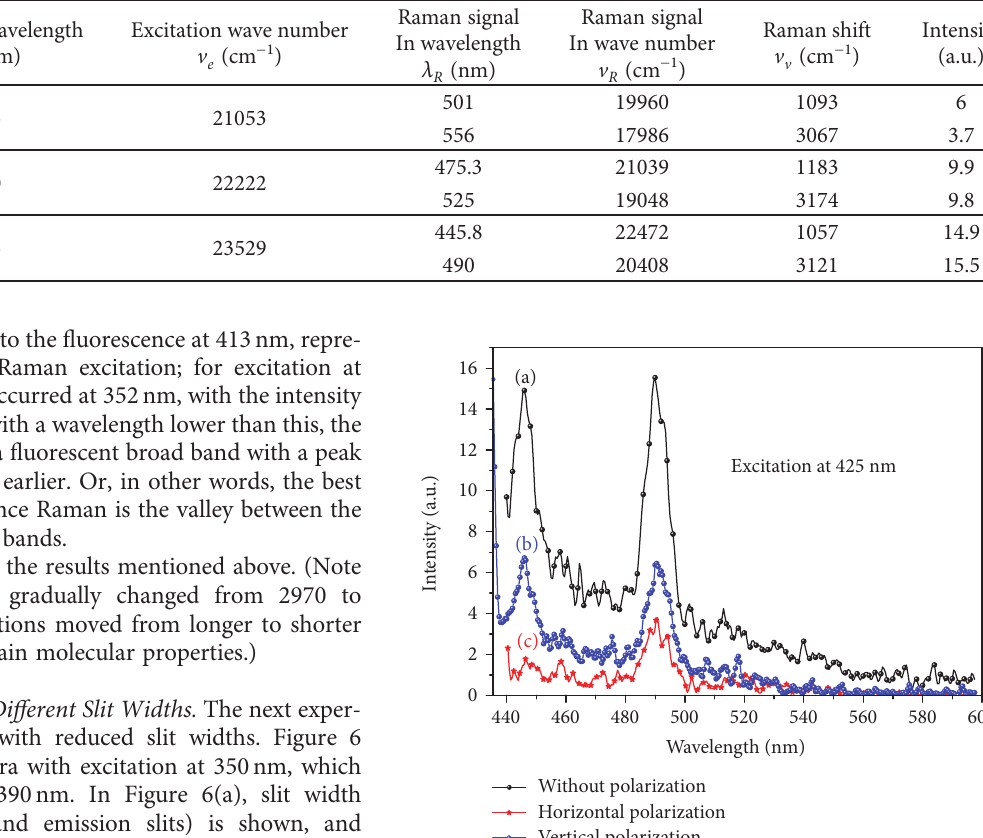
Table 2: Raman spectra for benzene.